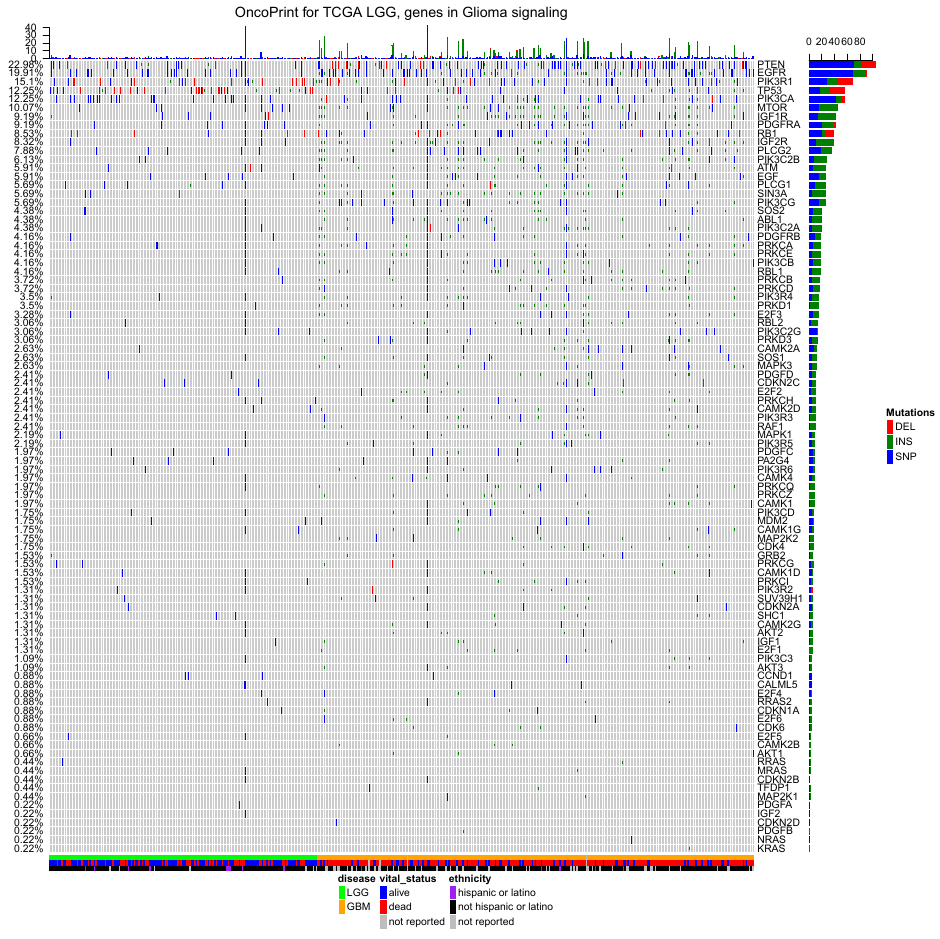
Figure 2. Oncoprint for LGG samples. Blue defines SNP, green defines insertions and red defines deletions. The upper barplot shows the number of these genetic mutations for each patient, while the right barplot shows the number of genetic mutations for each gene. The bottom bar shows the group of each